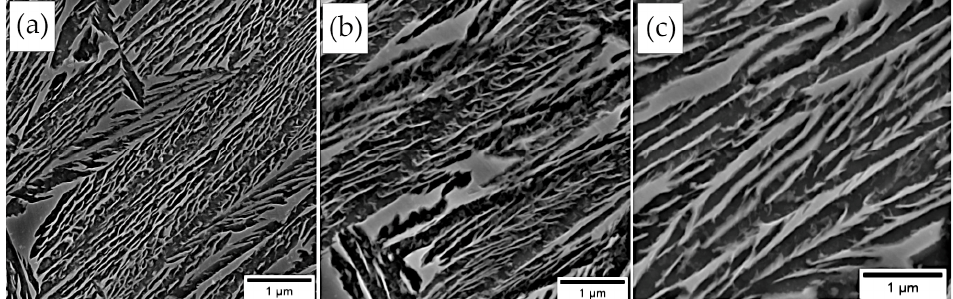
Figure 9. Micrographs of bainitic ferrite laths in di ff erent transformation temperatures: ( a ) 275 °C; ( b ) 325 °C; ( c ) 375 °C. Scanning electron microscopy, etched by nital.